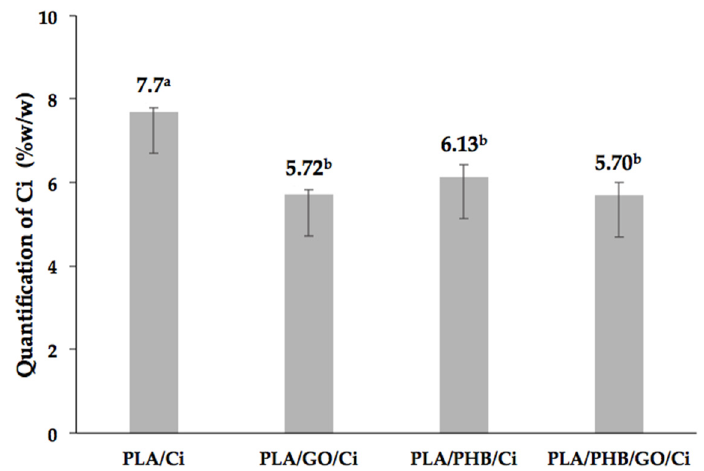
Figure 1. Quantification of impregnated cinnamaldehyde (% w / w ) in processed films and blends at process conditions of 12 MPa pressure and 1 MPa min − 1 depressurization. Mean value ( n = 3). Parameters in bar chart denoted with the same letters (a–b) do not differ statistically at the level of confidence 0.05.